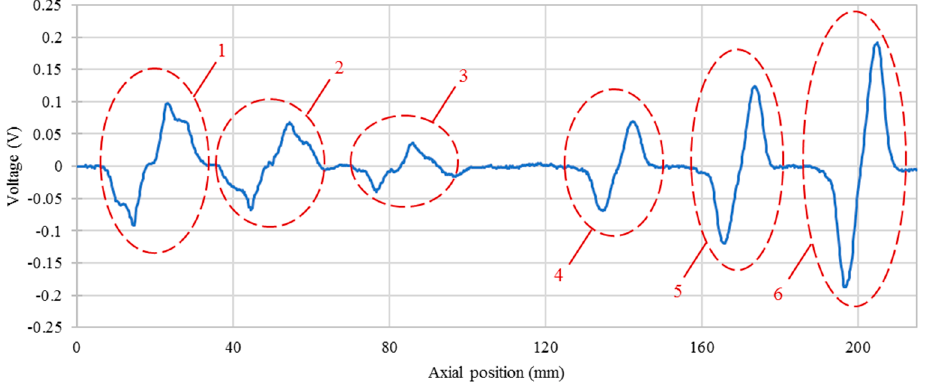
Figure 8. Output voltage of a differential sensing pair along a linear sweep of the sensor position at 0.9 MHz. 1—2.0 mm, longitudinal defect; 2—1.0 mm, longitudinal defect; 3—0.5 mm, longitudinal defect; 4—0.5 mm, transverse defect; 5—1.0 mm, transverse defect; 6—2.0 mm, transverse defect.